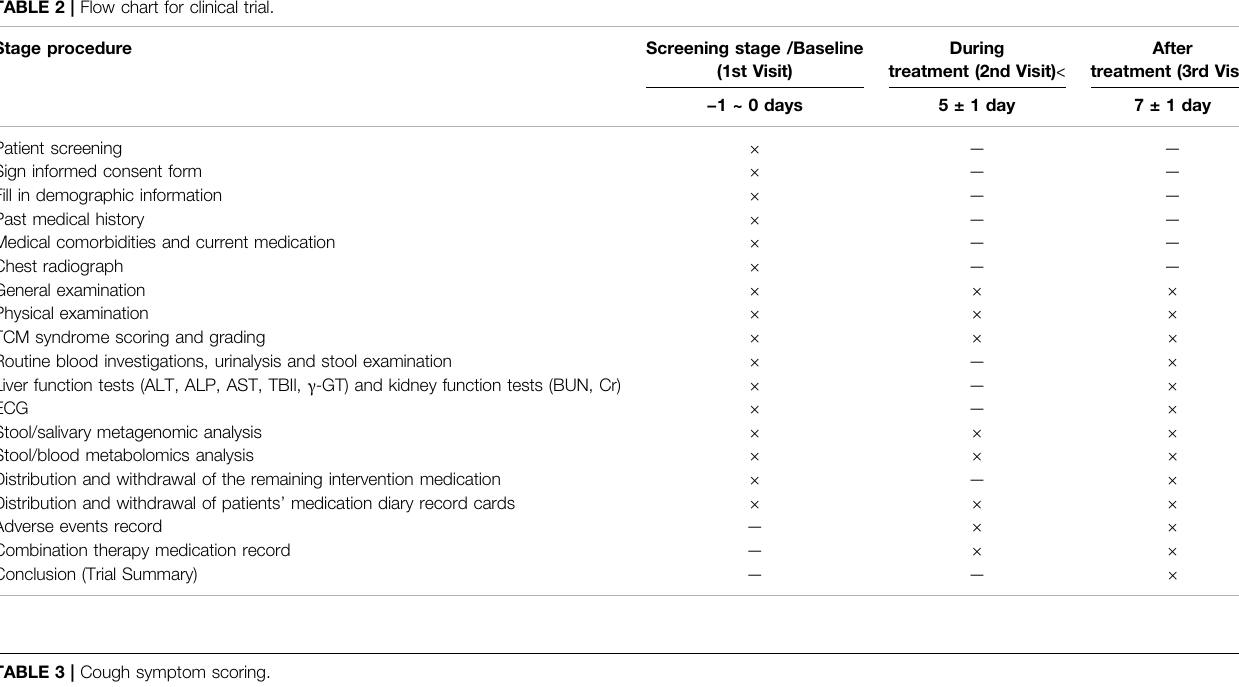
TABLE 2 | Flow chart for clinical trial.